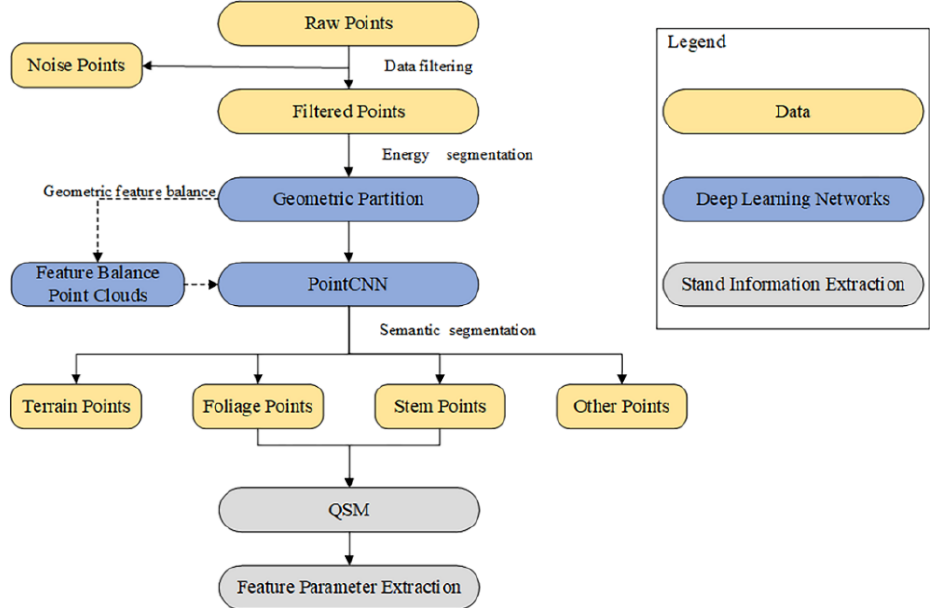
Figure 1. Main steps for the feature parameter extraction of artificial forest based on deep learning.